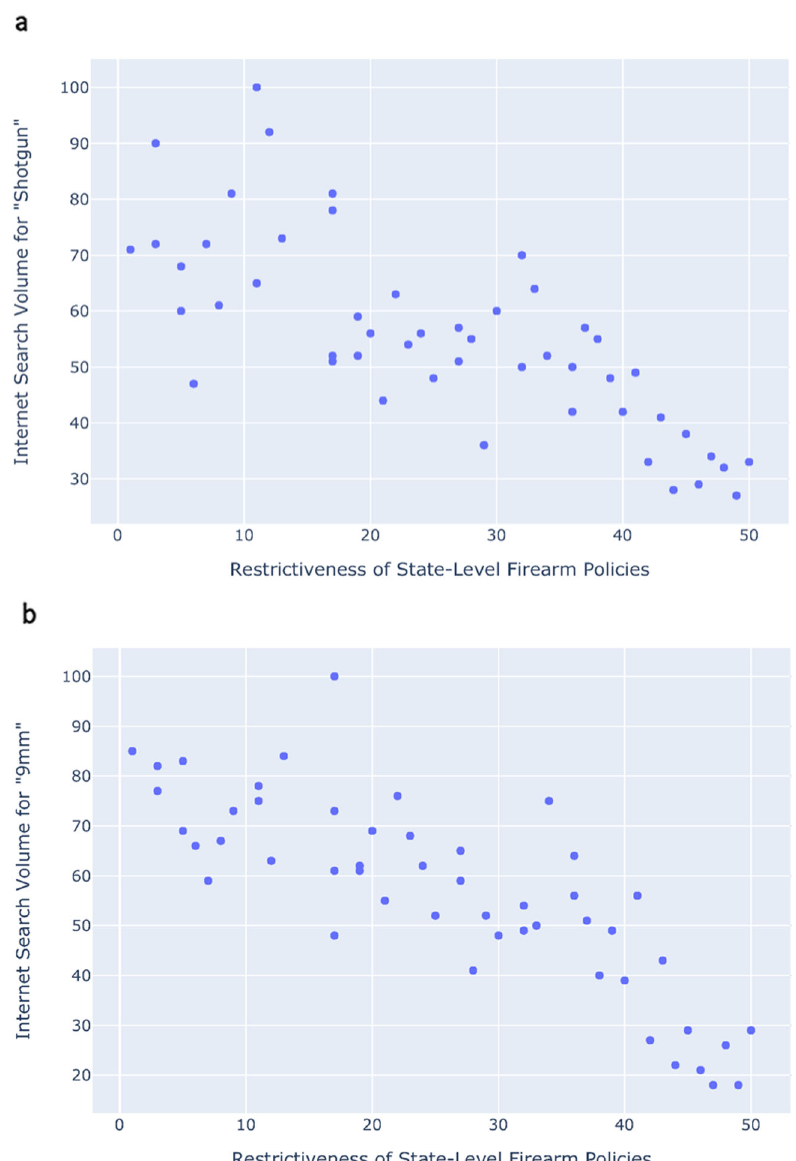
Fig. 6 State-level fi rearm policies vs. search volume. a Restrictiveness of state-level fi rearm policies, based on The Giffords Law Center to Prevent Gun Violence 2019 Annual Gun Law State Scorecard (1 – 50 scale) vs. Internet search volume for the terms shotgun (Pearson ’ s r = 0.76, Spearman ’ s ρ = − 0.78). b The same analysis shown for the search term 9 mm (Pearson ’ s r = − 0.82, Spearman ’ s ρ = − 0.83). All data from